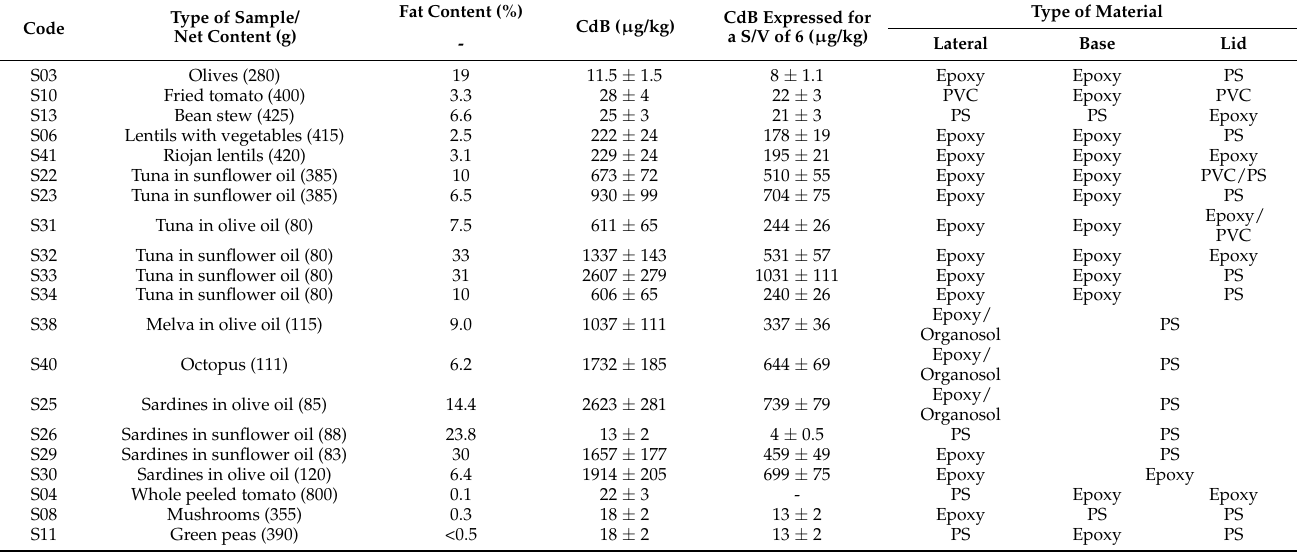
Table 2. Concentration of CdB ( µ g/kg) in the positive canned food samples and the type of coating identified in their corresponding